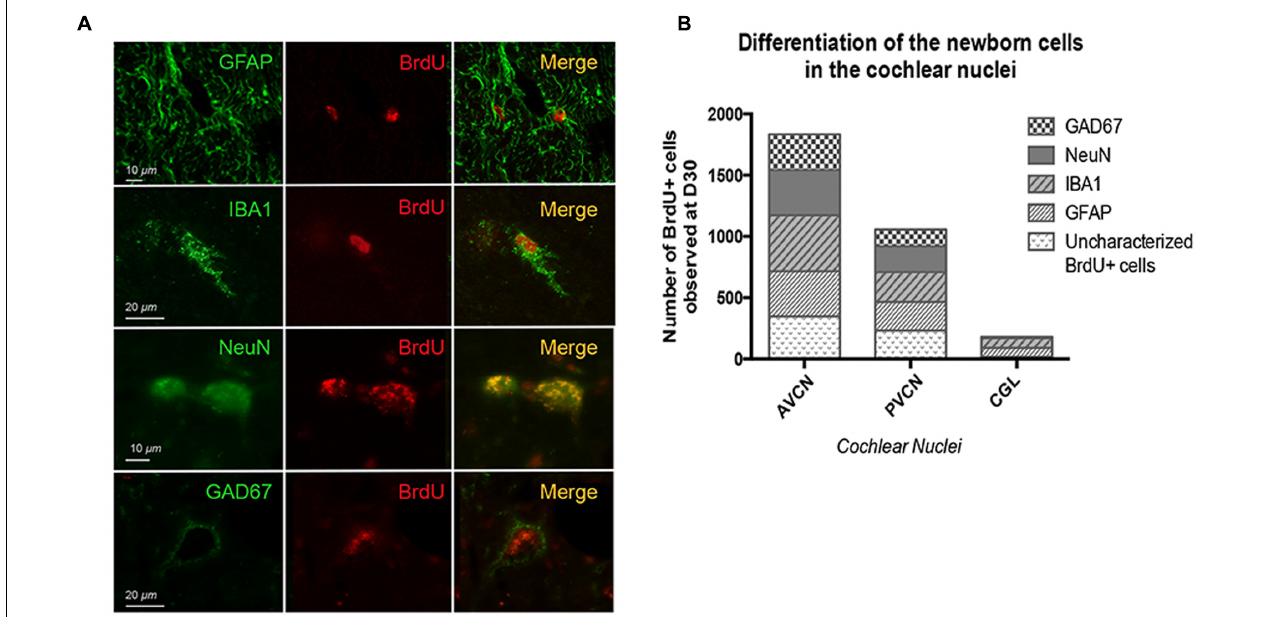
FIGURE 5 | Thirty days after UCN, glial fibrillary acidic protein (GFAP) and glutamic acid decarboxylase (GAD67) immunoreactivity are differentially expressed in the cochlear nuclei of cats submitted to a cochlear neurectomy. (A) Double immunostaining confocal analysis of differentiated newly generated cells processed on consecutive serial sections. The BrdU + nuclei are in red and the other markers of differentiation: GFAP + , IBA1 + , NeuN + , and GAD 67 + in green. Illustrations were made in the deafferented AVCN nucleus of cats 30 days after cochlear neurectomy. (B) Histograms illustrating the percentage of GFAP, IBA1, NeuN, and GAD67 positive cells among the BrdU positive cells observed in the different sub-divisions of CN.